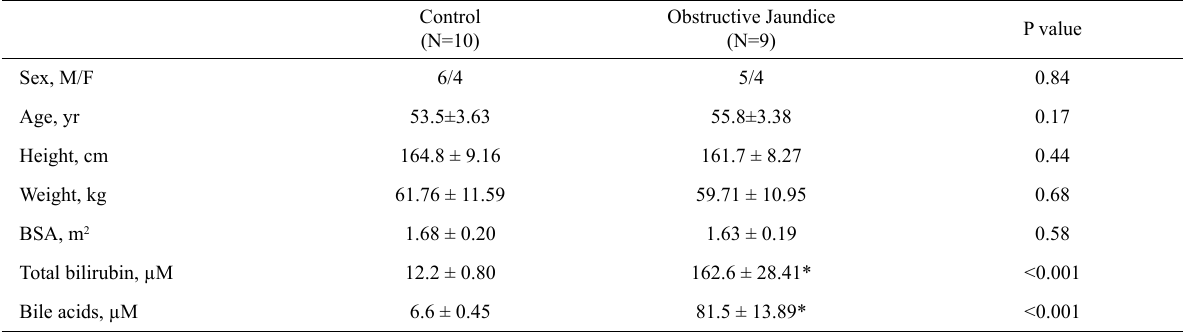
Table 1 - Demographic data.